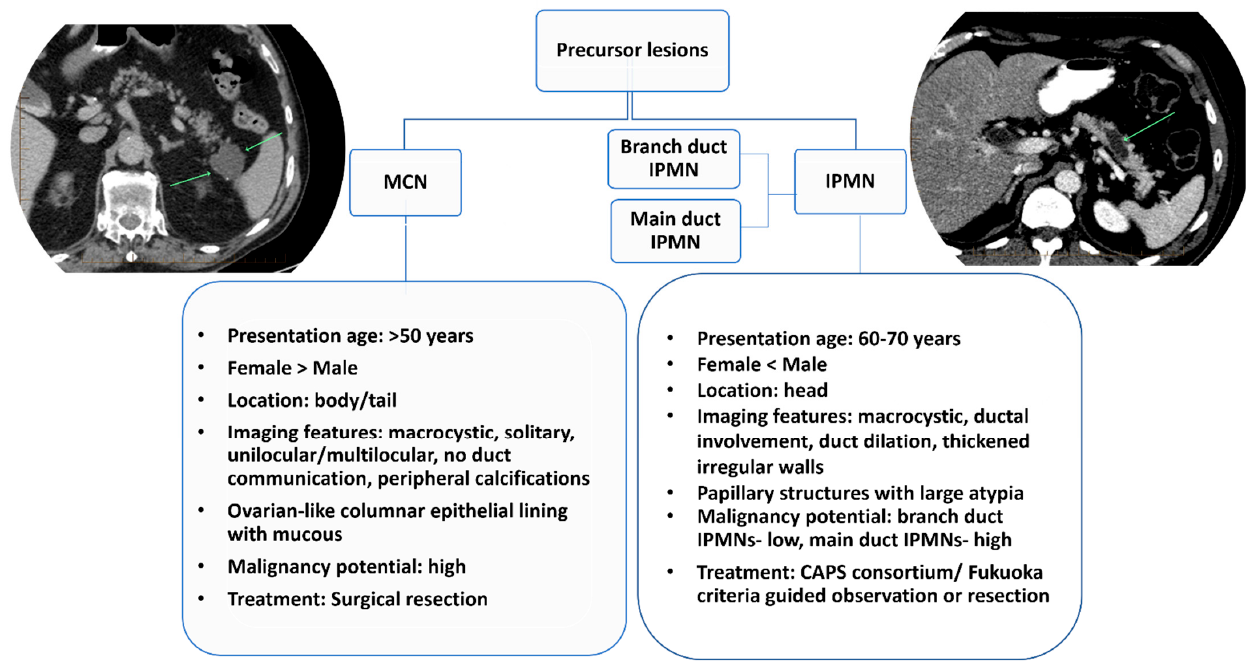
Figure 2. Characteristics of pancreatic cystic lesion types and their key differences. IPMN= intraductal papillary mucinous neoplasms; MCN= mucinous cystic neoplasms.